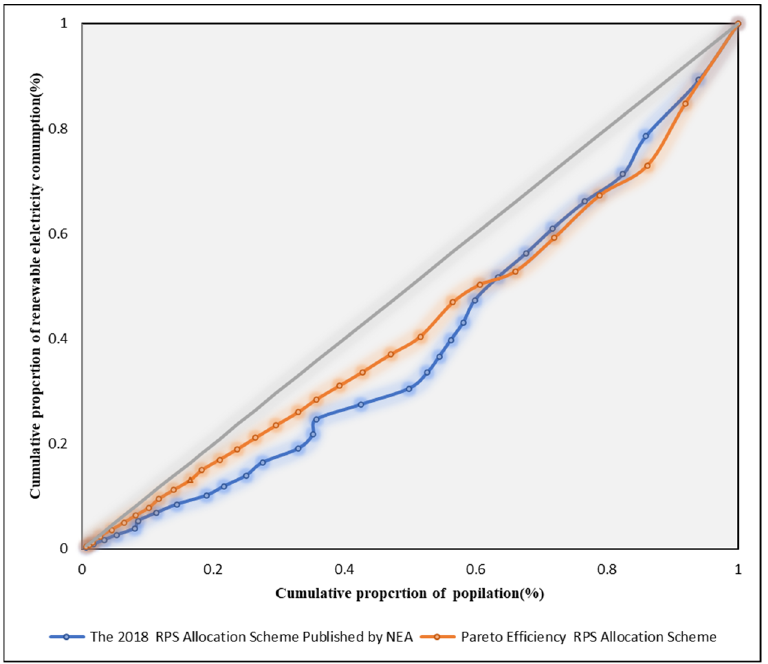
Figure 5. Loren Curve of Per Capita Renewable Energy Electricity Consumption in 2018.